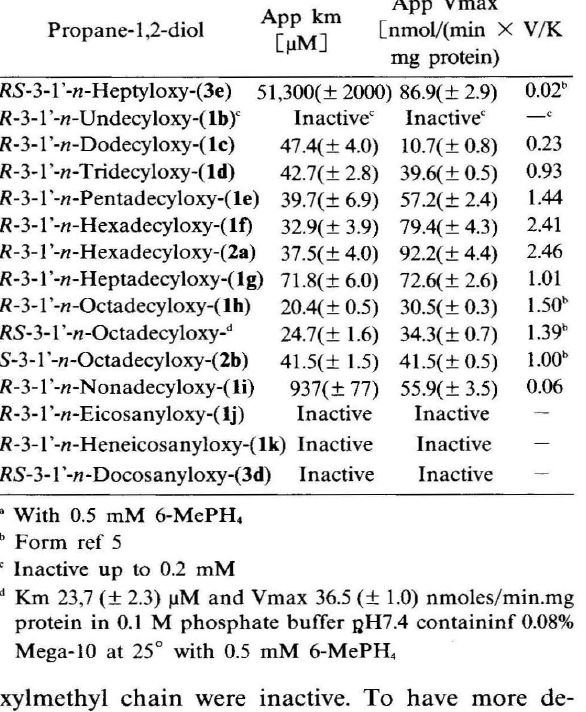
Table 1. Kinetic parameters of glyceryl-ether monooxygen ase with glyceryl ether substrates in 0.1 M Tris-HCI buffer containing 0.08% Mega-lO at pH 7.5 and 25't'